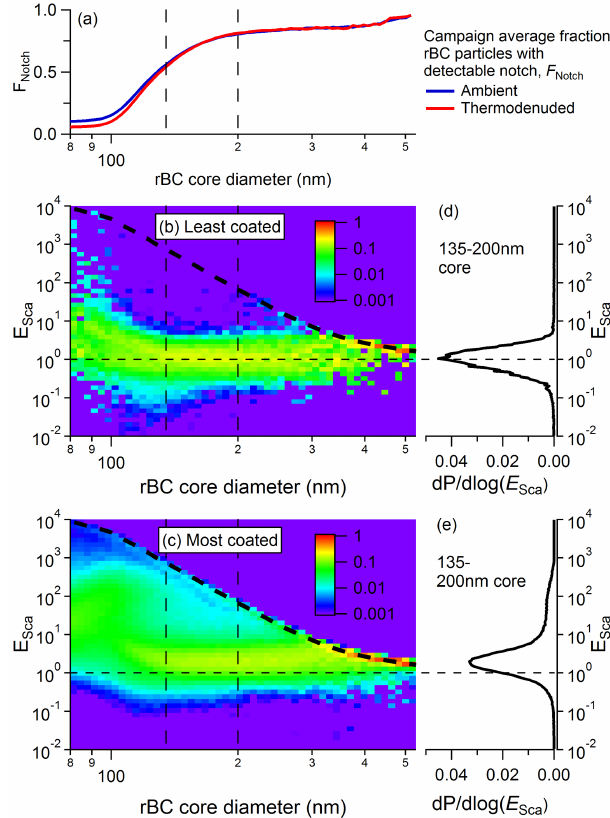
Figure 3. Diagnostics for determining the range of rBC core diam- eter used for Mie modelling. Panel (a) shows the fraction of rBC- containing particles with detectable notch positions, averaged over the whole campaign, as a function of D C . Panels (b) and (c) show probability density functions, d P/ dlog (E Sca ) for each core diame- ter bin, under the least processed (particles drawn through the ther- modenuder >220 ◦ C and − log ( NO x / NO y ) <10th percentile) and most processed (ambient inlet and − log ( NO x / NO y ) >90th per- centile) conditions respectively. The thick dashed black lines rep- resent the calculated saturation of the scattering detector at 5% of maximum laser intensity. Panels (d) and (e) are d P/ dlog (E Sca ) distributions for particles in the range 0.135 ≤ D C <0.2µm, bor- dered by the vertical dashed lines. The horizontal dashed lines show a core scatter ratio of 1. Panels (b) and (c) are scaled in arbitrary units, and are normalized such that each column sums to 1. Panels (d) and (e) are also normalized to sum to 1, though they are distri- butions over the range 0.135 ≤ D C <0.2µm, rather than averages of (b) and (c) , and are thus weighted more heavily towards the smaller particles within the range. Panels (b–e) were calculated assuming ρ C = 1.8gcm − 3 and n C = (2.26–1.26 i